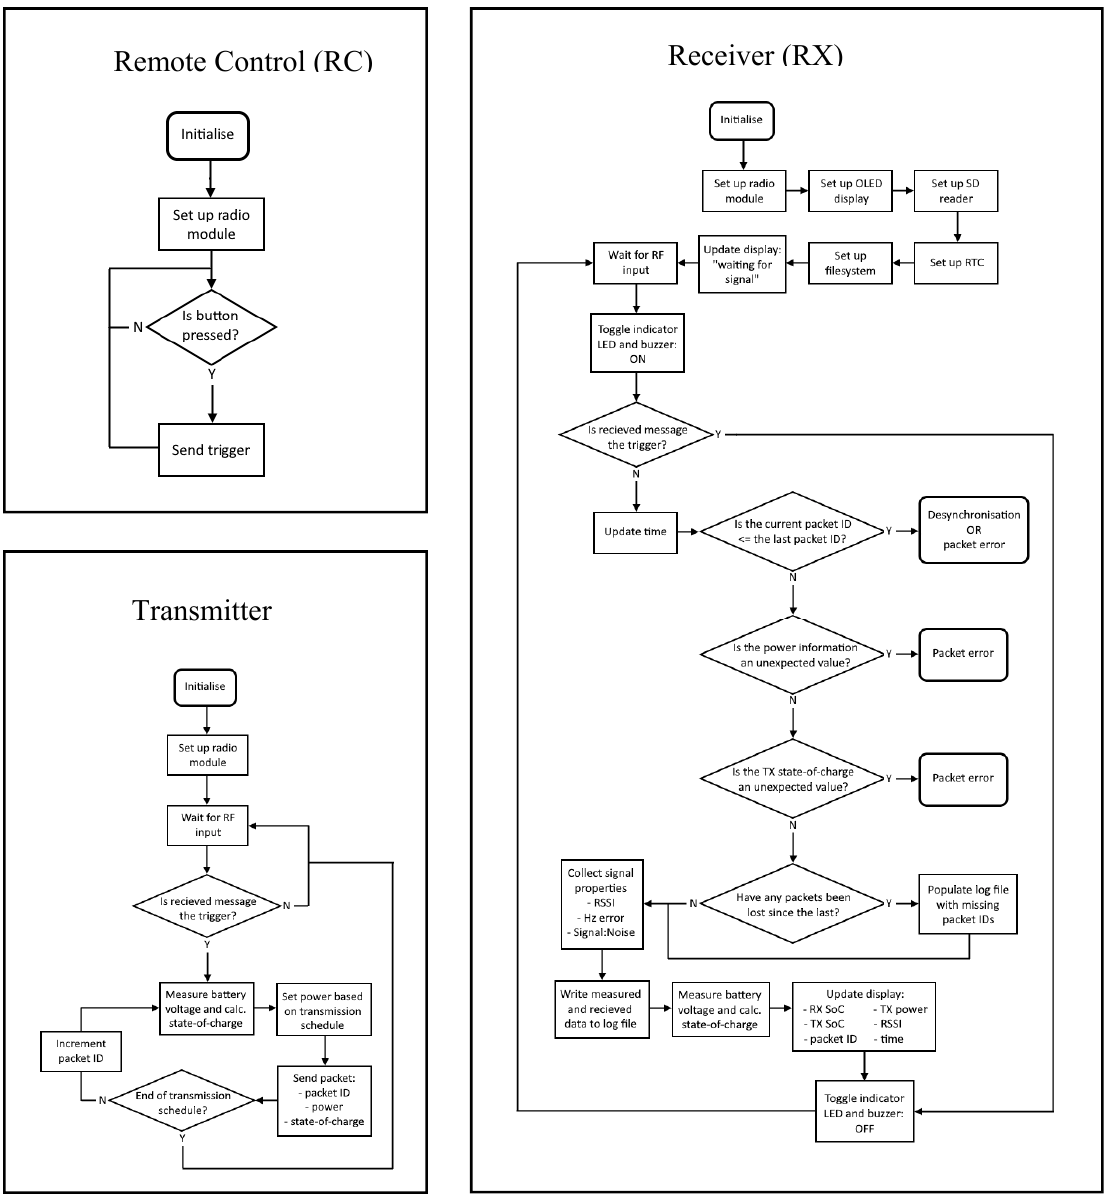
Figure 2. Flow diagram of remote control, transmitter and receiver node software.